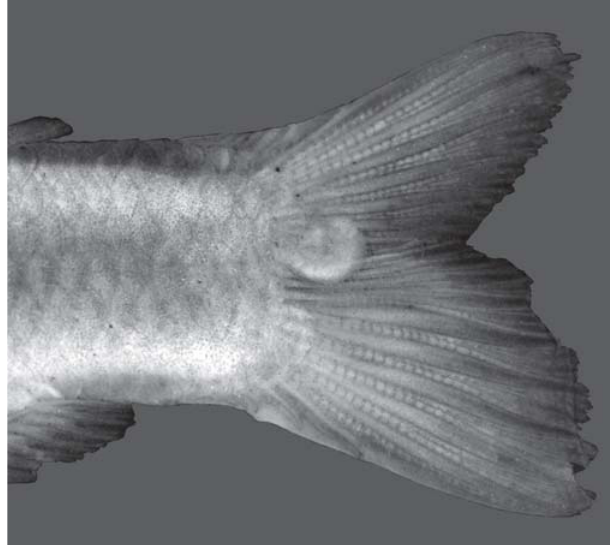
Fig. 22. Glandulocauda caerulea , adult male, USNM 326756, 43.9 mm SL; caudal fin and caudal